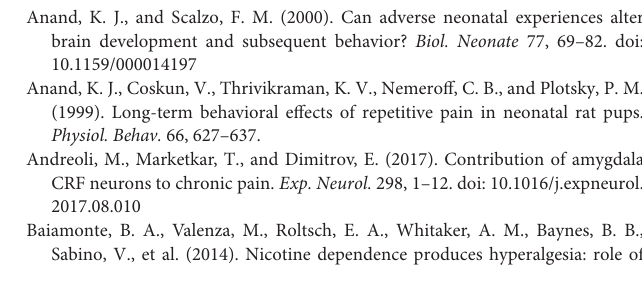
Supplementary Figure 1 | Quantification of FISH Product c-fos within the amygdala under neonatal conditions (Pain, Handled, and Undisturbed) and juvenile conditions (basal and fear conditioned) in PND 24 rats. (A) Number of c-fos positive cells within CeA. (B) Number of c-fos positive cells in the BLA. N’s